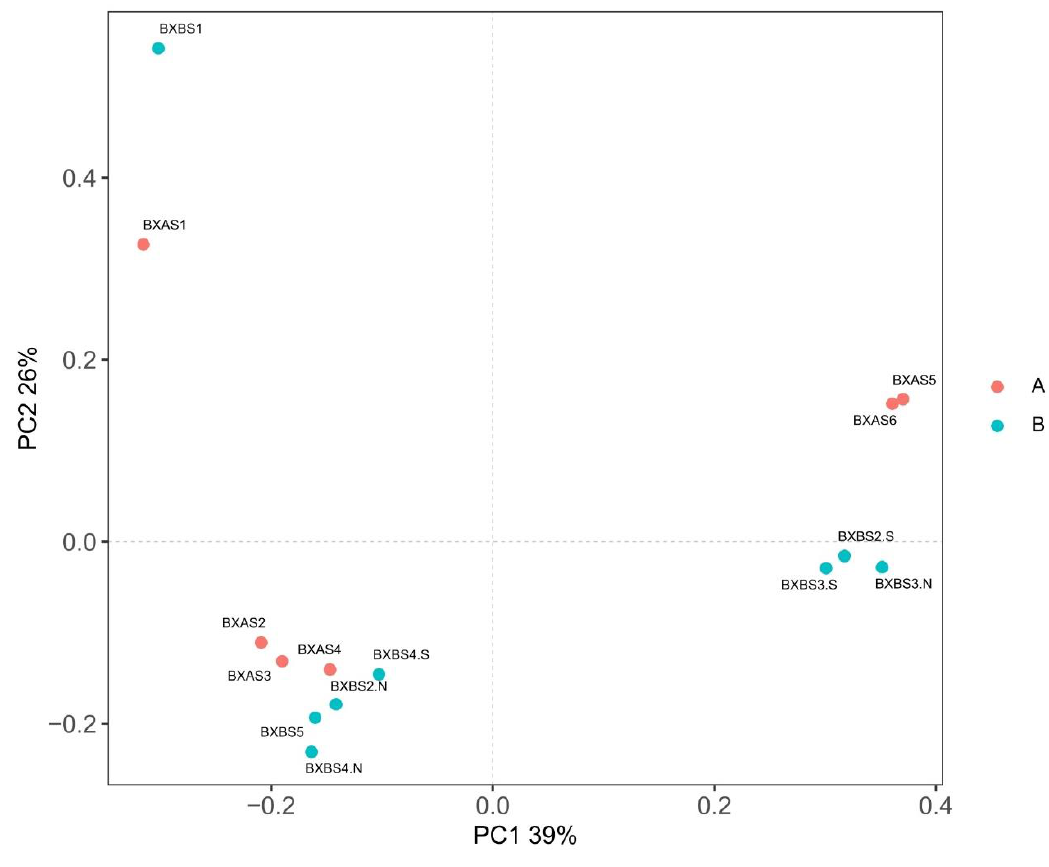
Figure 3. Principal coordinate analysis (PCoA) of samples.